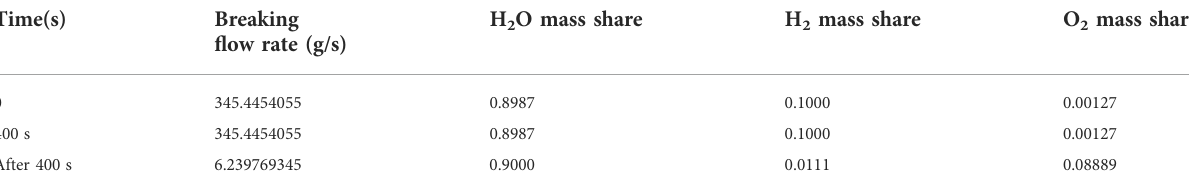
TABLE 1 Condition one breakout fl ow parameters.